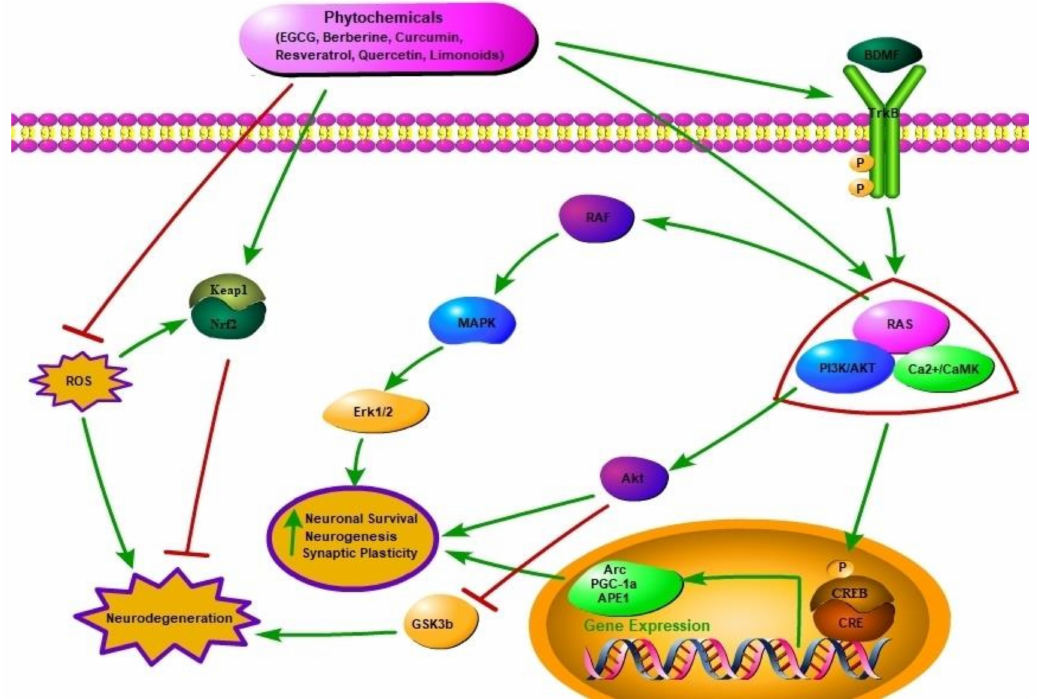
Figure 2. Two sites action of phytochemicals on alleviating progression of neurodegenerative diseases. Activation of TrkB receptor by BDNF or Phytochemicals induces PI3K/Akt kinase signalling and Ras, Raf and ERK pathways resulting in protecting neurons from degeneration. BDNF activates transcription factor-CREB which further induces the expression of Arc (synaptic plasticity), PGC-1 α (cellular energy metabolism) and APE1 (DNA repair